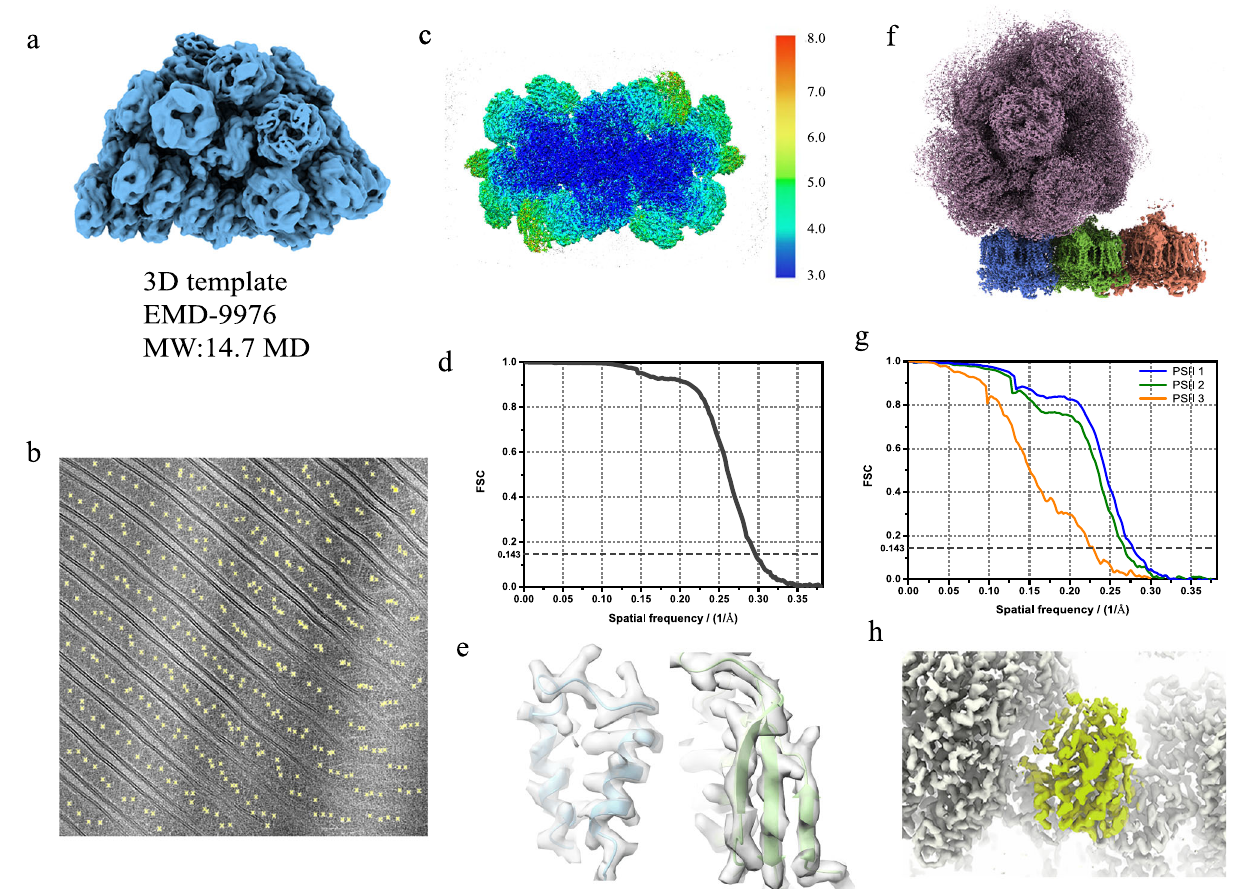
Fig. 2 | Localization and high-resolution reconstruction of PBS-PSII complex. a 3D PBS model (EMD-9976) used in the projection matching, and the molecular weight is about 14.7 MD. b Locations on the image from projection matching at threshold 8. c Isosurface of the 3.4Å-resolution PBS map colored by local resolu- tion, showing a high resolution near the core and a lower resolution outside may duetothe fl exibility. d TheFSCcurveofPBSstructure. e High-resolutionfeaturesof PBS map fi tted by pdb 6kjx, such as amino-acid side chains (left) and β -strands